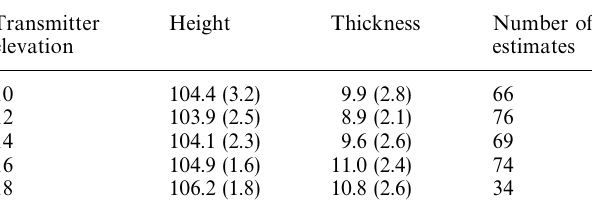
Table 2. Mean scattering layer height and thickness (standard devi- ation in